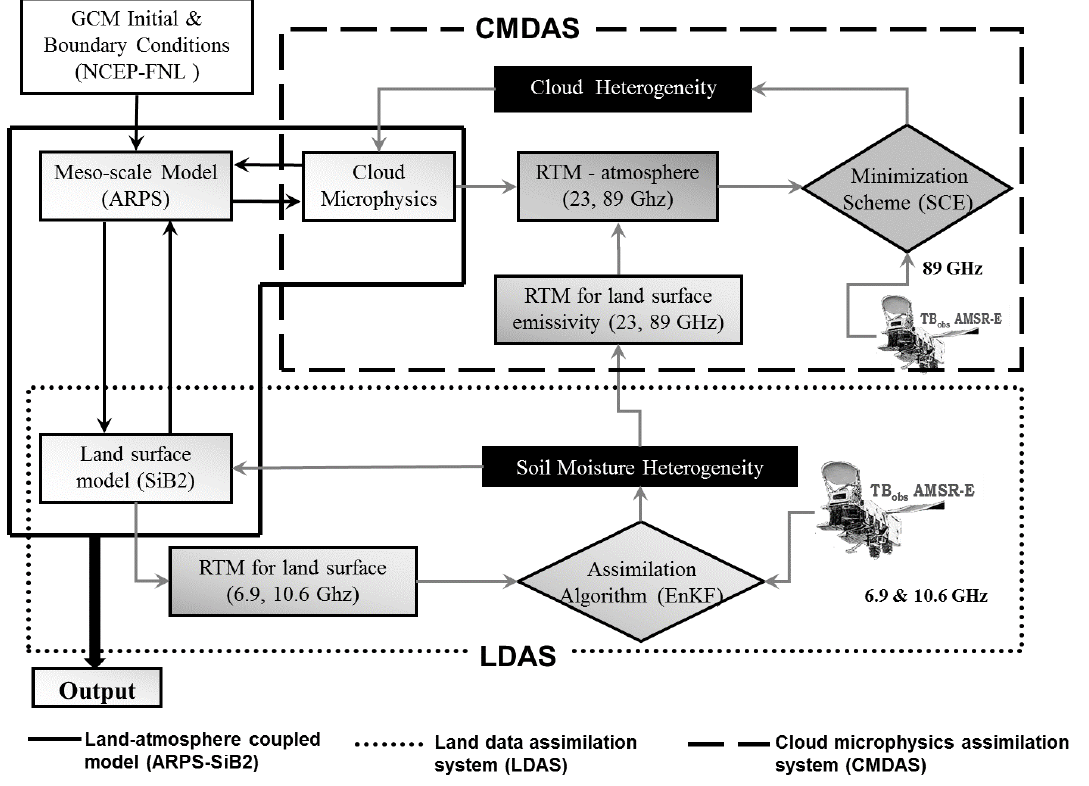
Figure 1. Schematic diagram of the Coupled Atmosphere and Land Data Assimilation System